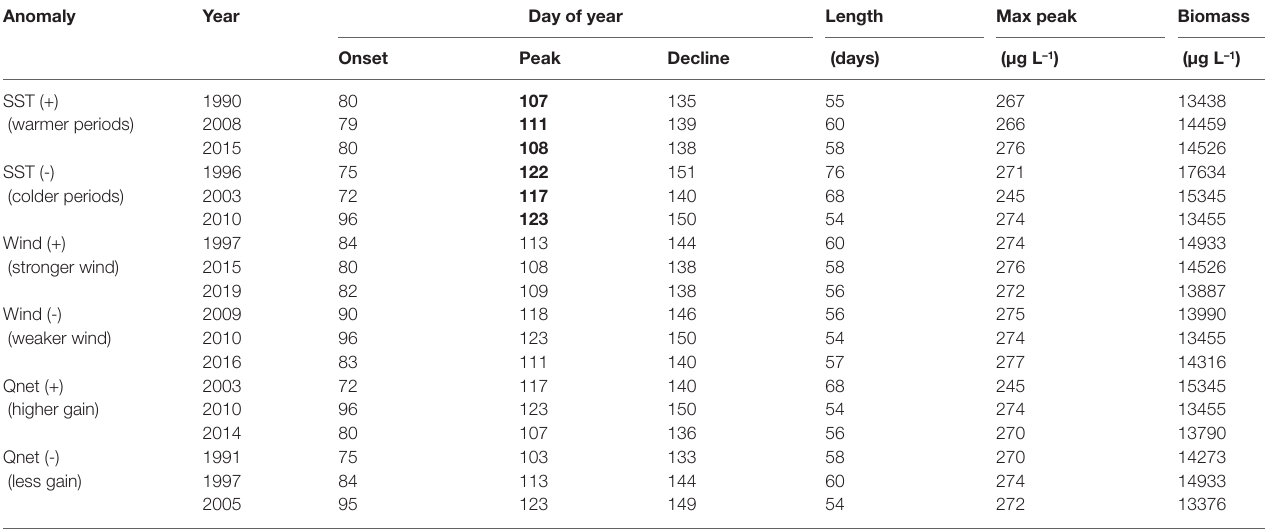
TABLE 4 | Diatoms biomass integrated over the bloom period (February-May) calculated for the periods with the highest (+) and smallest (-) anomalies in SST, wind and net heat flux (Qnet). Anomaly